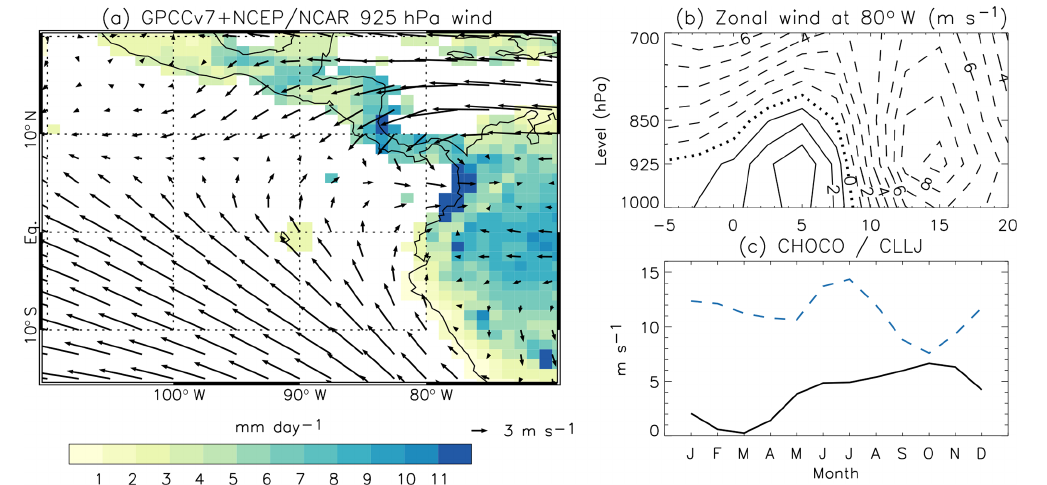
Figure 1. (a) Average NCEP-NCAR wind vector at 925hPa for the period 1981–2010 shading shows the corresponding average GPCCv7 precipitation; (b) 1981–2010 average cross section of the zonal wind from 5 ◦ S to 20 ◦ N at 80 ◦ W. Positive/negative (westerly/easterly) zonal wind is indicated by continuous/dashed contours; (c) 1981–2010 average monthly evolution of the zonal wind at 5 ◦ N, 80 ◦ W and 925hPa (CHOCÓ, black line) and zonal wind (change of sign) at 15 ◦ N, 75 ◦ W and 925hPa (CLLJ, blue dashed line).